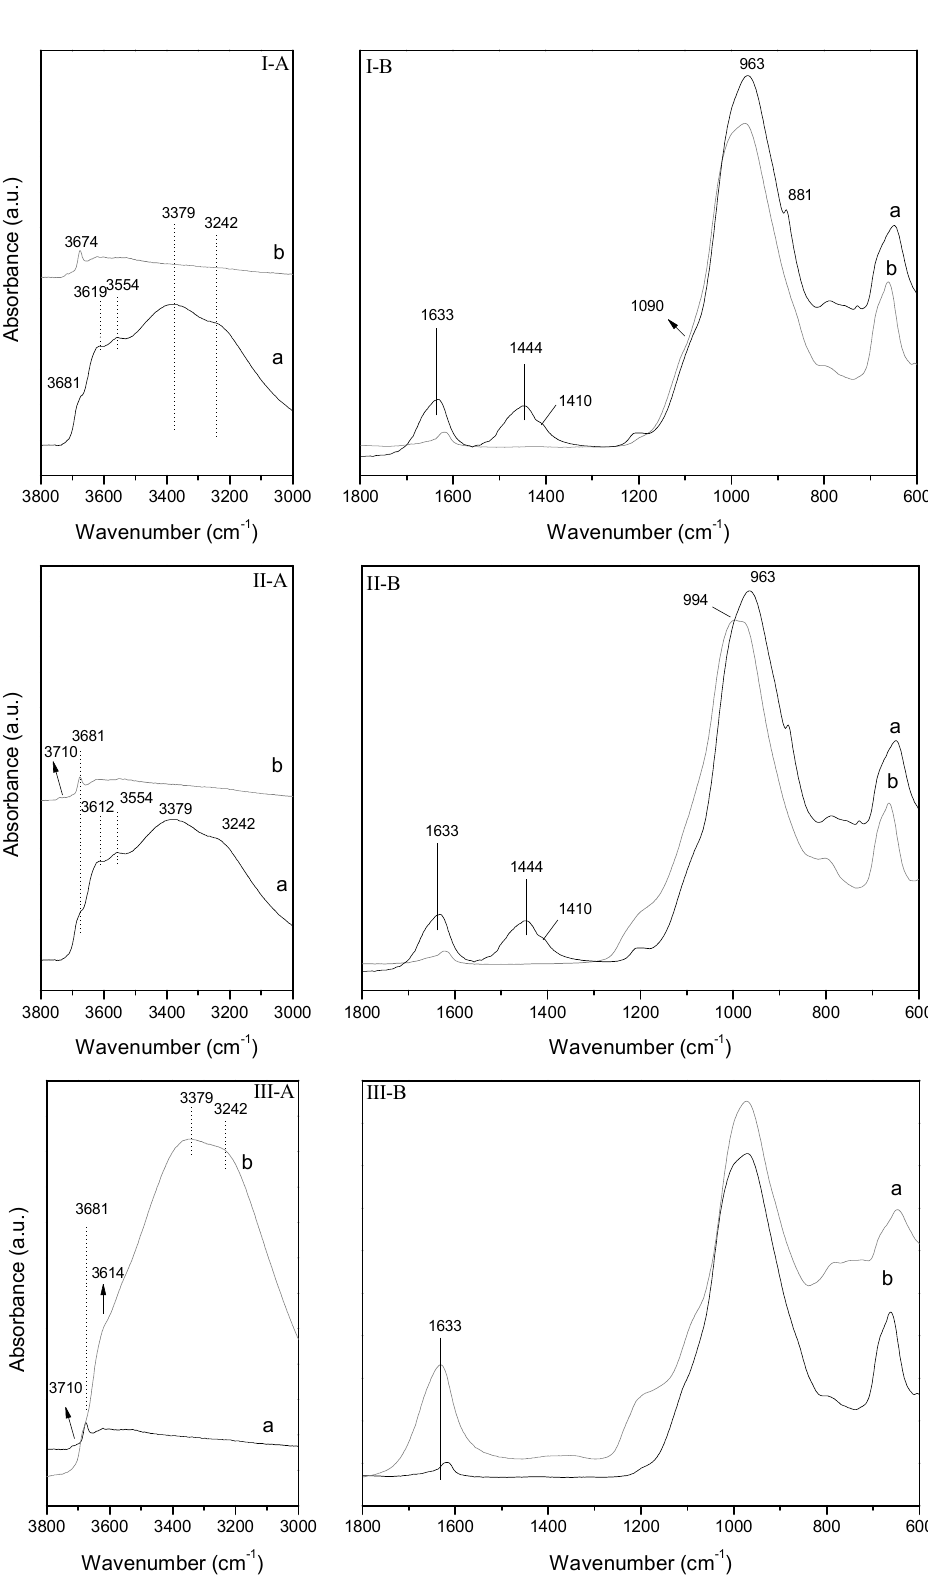
Figure 7. ( I ) Comparison of DRIFT spectra of natural Sepiolite ( a ) vs. Sp–H ( b , red); ( II ) comparison of DRIFT spectra of natural Sepiolite ( a ), Fe–Sp ( b , grey) and ( III ) comparison of DRIFT spectra of Sp–H ( a ) vs. Fe–Sp–H ( b , grey).